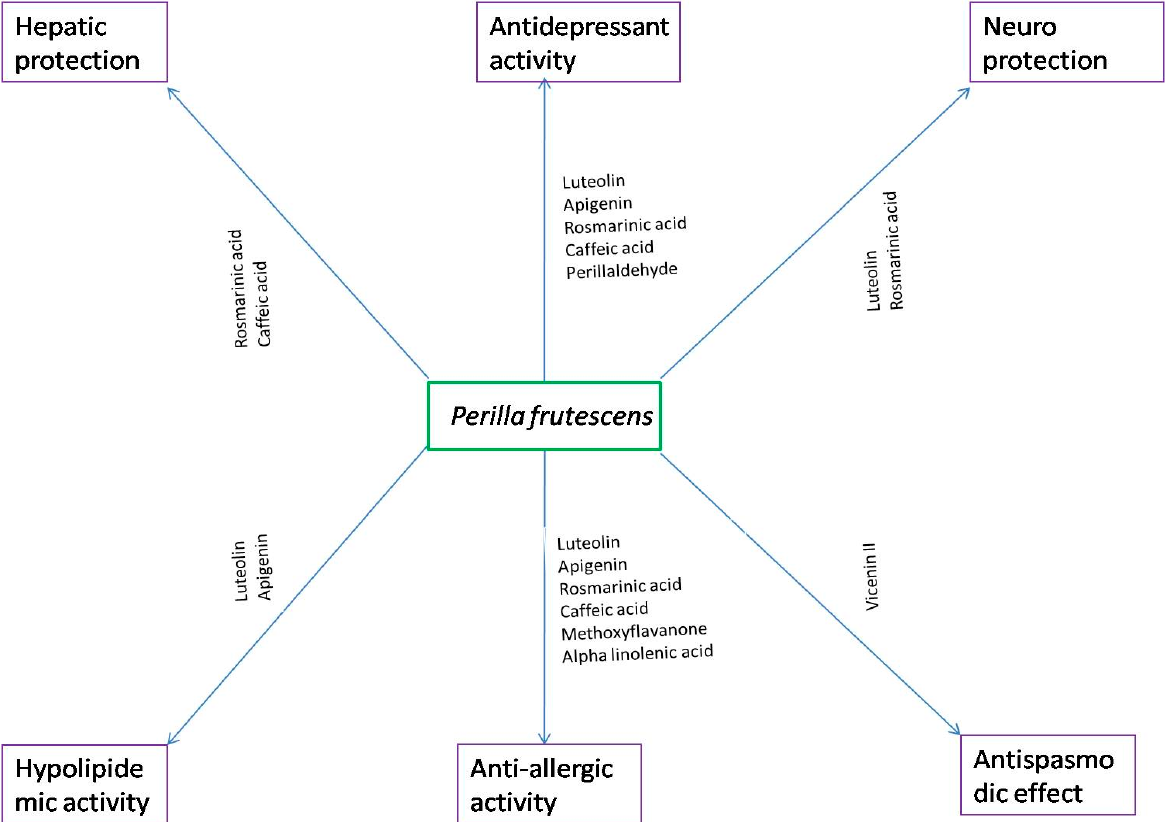
Figure 2. Different bioactive compounds of P. frutescens , exhibiting different biological functions, including antiallergic activity, antidepressant activity, antispasmodic effect, hypolipidemic, hepa- toprotection, and neuroprotection activities.